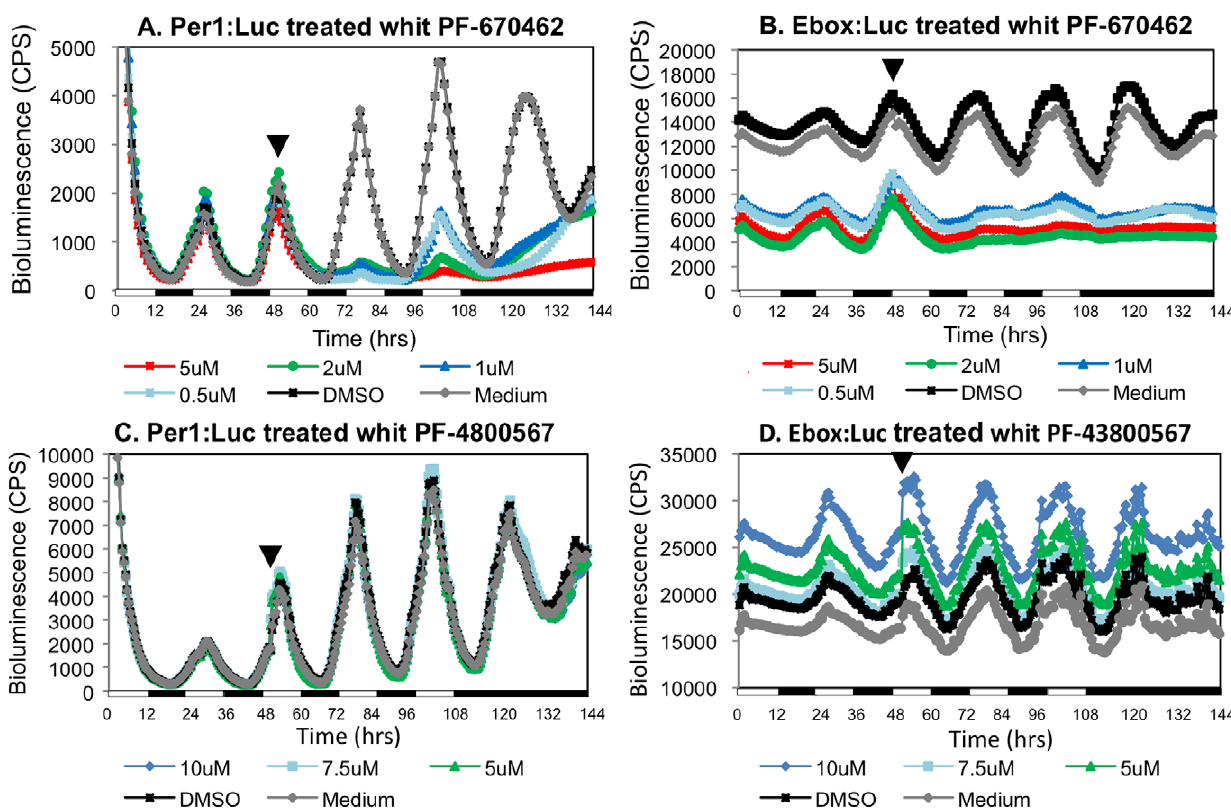
Figure 1. CK1 d inhibition disrupts the PAC-2 cell circadian clock. Dose-response of PF-670462, a pan-CK1 d / e inhibitor and PF-4800567, a selective inhibitor of CK1 e , in the zebrafish PAC-2 cell line. Bioluminescence assay of cells transfected with per1b:Luc (A and C) or Ebox:Luc (B and D), and treated with PF-670462 (A and B) or with PF-4800567 (C and D) at the indicated time (arrow). Cells were maintained under LD cycles, and then the inhibitor was added to the cell culture 1.5 h before lights on (black arrows) at different concentrations (PF-670462: 0.5 m M- light blue line, 1 m M- blue line, 2 m M-green line, 5 m M- red line. PF-4800567: 5 m M- green line, 7.5 m M- light blue line and 10 m M- blue line). Controls were treated with DMSO (black line) or with culture medium (gray line). After three LD cycles cell were transferred to DD. Bioluminescence is plotted on the y-axis and time (hours) on the x-axis. White/black bars show the light and dark periods, respectively. Clock-controlled rhythmic promoter was disrupted by PF- 67046 but not by PF-4800567, thus CK1 d activity appears to be important for peripheral circadian clock